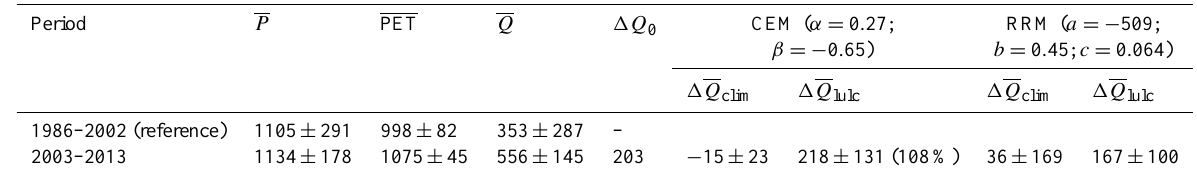
Table 4. Modeled contributions of land-use change and climate change to the increase in stream flow (mmyr − 1 ) by the climate elasticity model (CEM) and rainfall–runoff model (RRM).